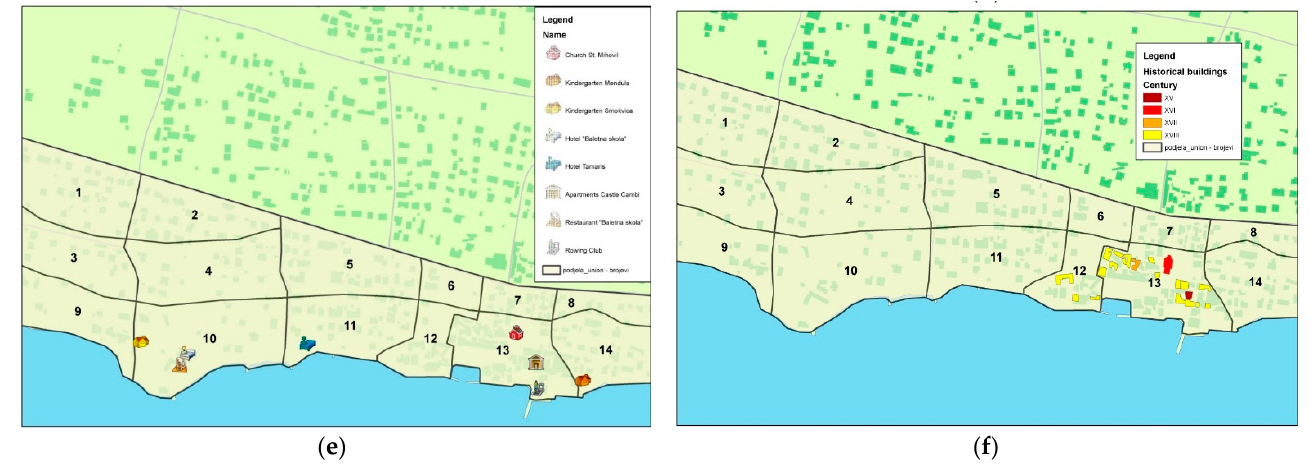
Figure 10. GIS analysis of additional criteria: ( a ) electricity supply; ( b ) water supply and drainage; ( c ) road network; ( d ) construction density; ( e ) importance factor (public, school, etc.); ( f ) historical buildings.